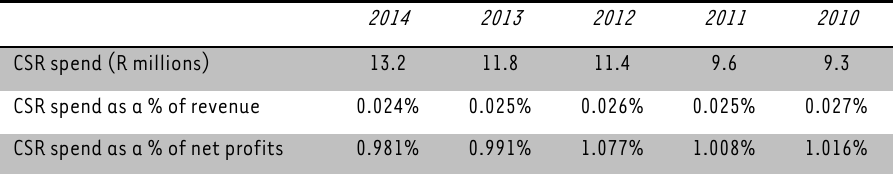
TABLE 3: SPAR CSR spending from 2010 to